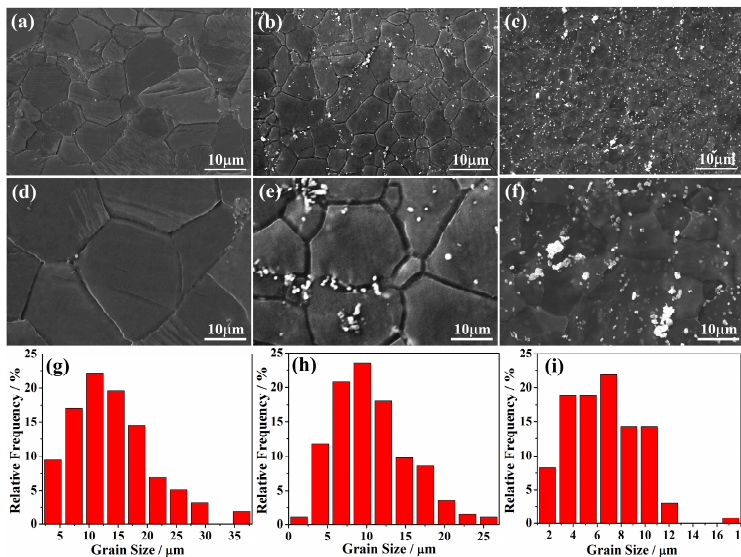
Figure 1. SEM micrographs of ( a ) Mg–1Sn–1Zn–0.5Ca, ( b ) Mg–3Sn–1Zn–0.5Ca, ( c ) Mg–5Sn–1Zn–0.5Ca,